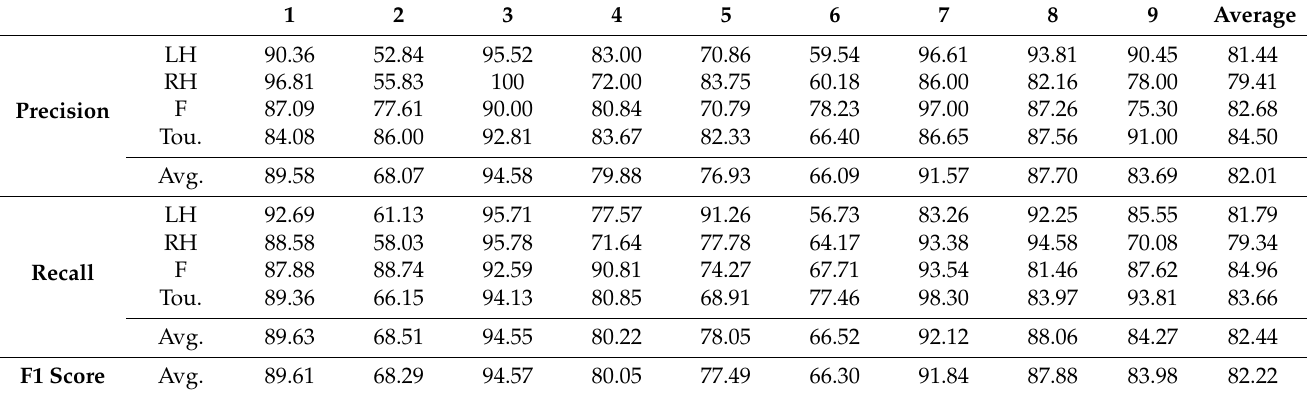
Table 4. Precision, recall, and F1 Score on the MI BCI IV-2a dataset using